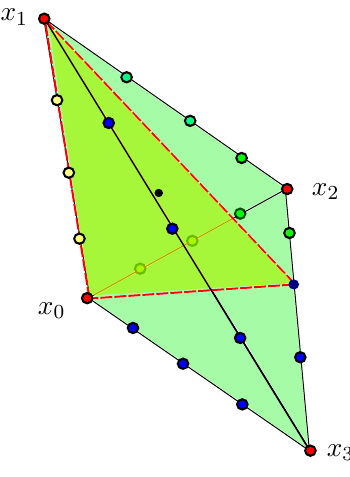
Figure 2 . Depiction of the mirror quartic polytope. Edge points are given in red and a slice of a 2D sub-polytope, that induces an elliptic fibration structure is highlighted. The six A 3 singularities between the vertices are grouped with respect to the elliptic fibration. Two e 7 tops are highlighted in green and blue respectively and another su 4 as yellow